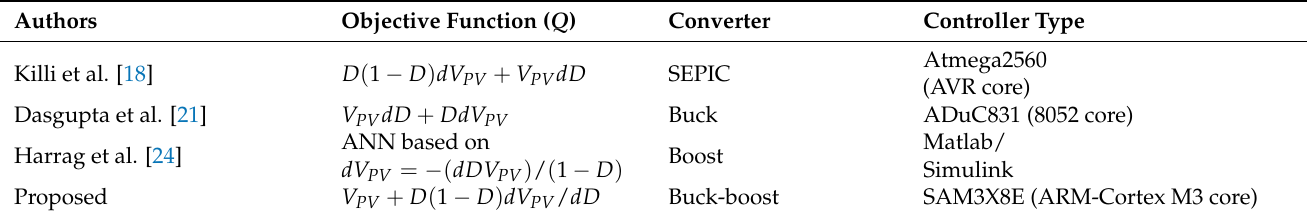
Table 2 summarizes the published voltage sensor-based MPPT methods using the concept of annulling the objective function ( Q ) derived from the mathematical model of the power converter used for tracking. Table 2. Review of different published current sensorless MPPT